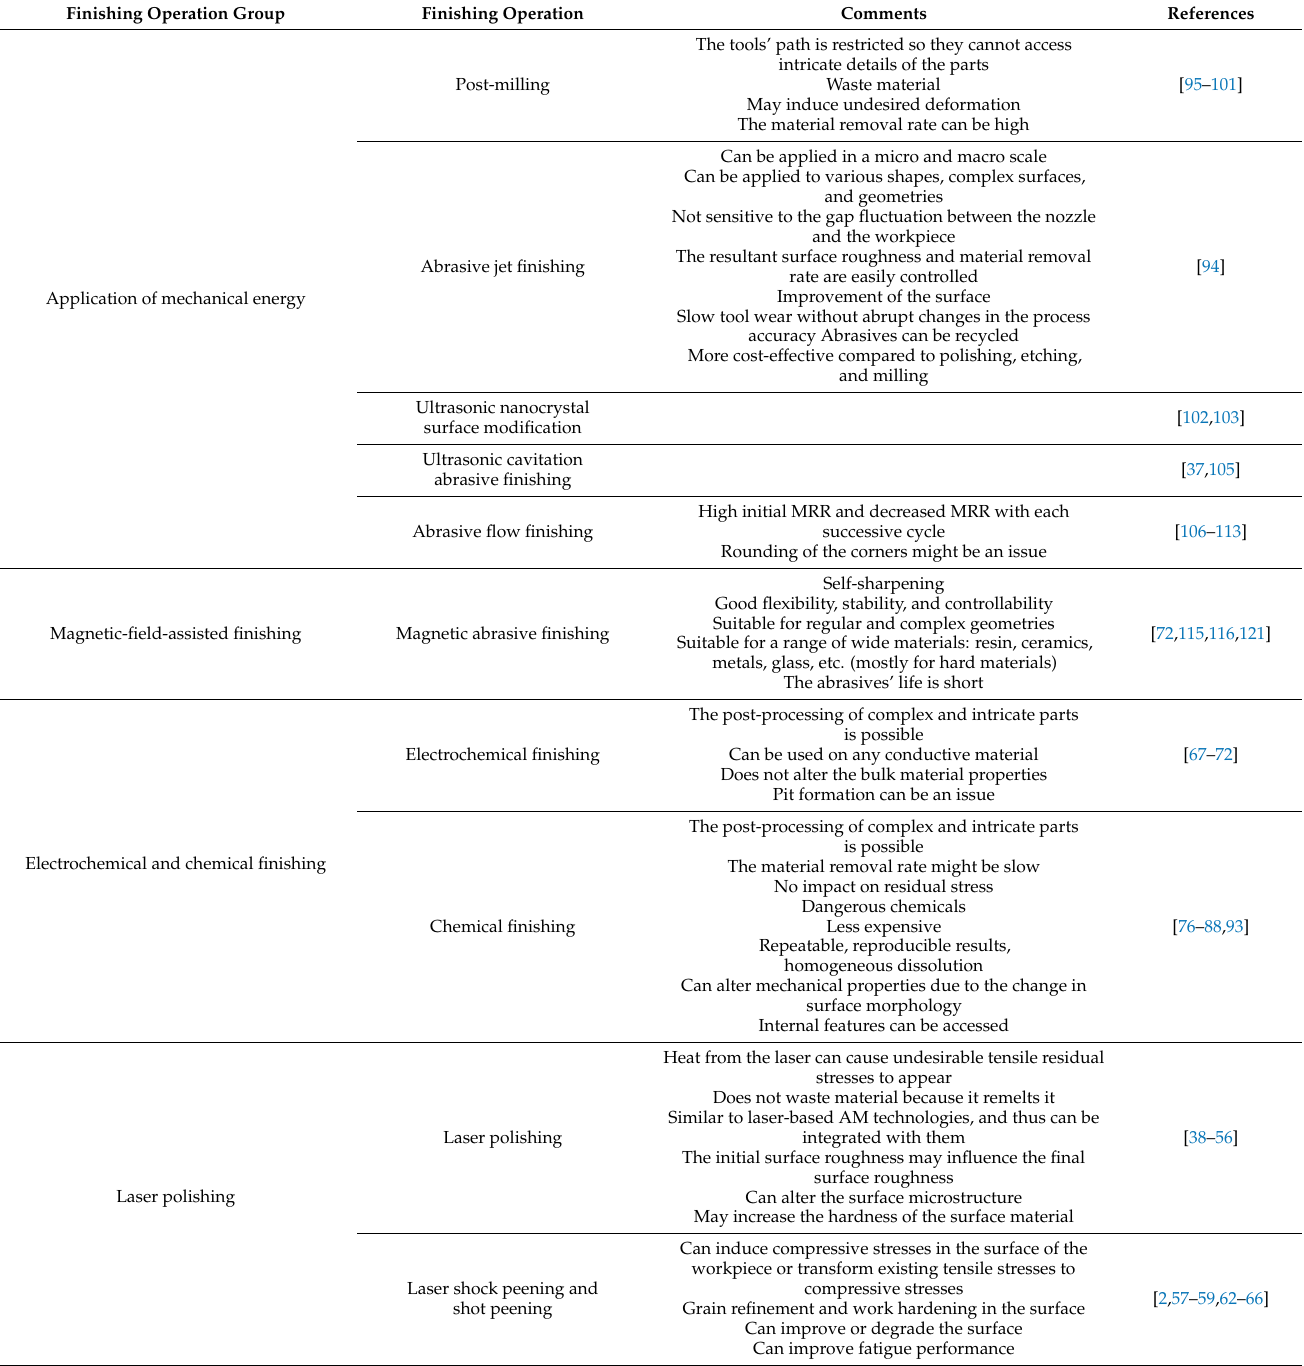
Table 2. Summary of the finishing processes for metal additive